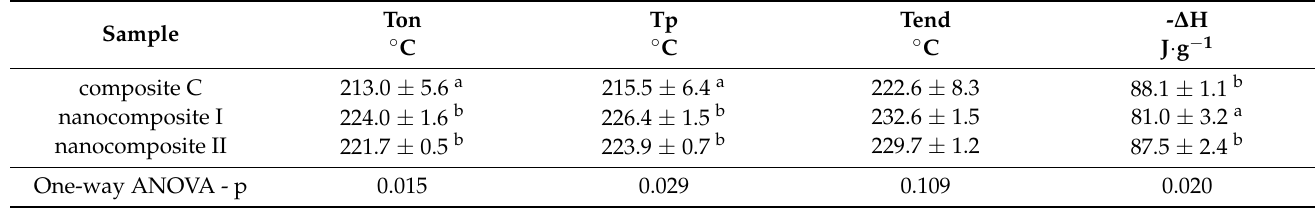
Table 4. Parameters of melting peak (Tp2).